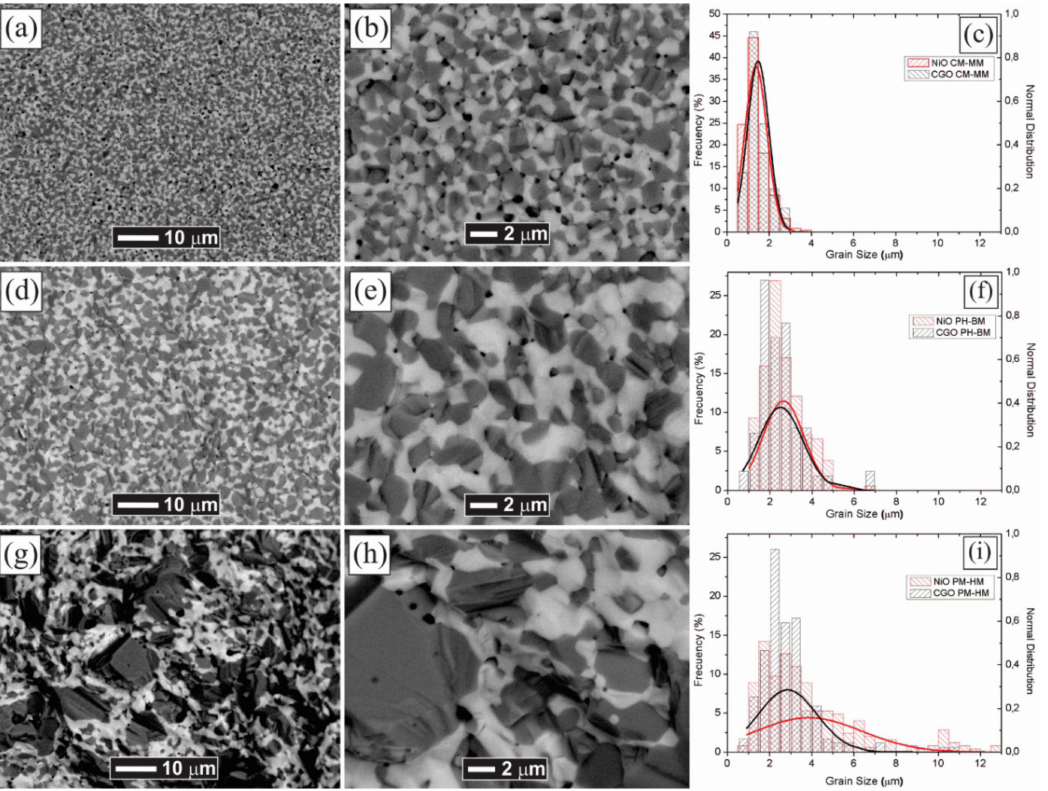
Figure 7. SEM images of the fracture surfaces for the sintered samples processed through ( a , b ) CM, ( d , e ) BM, and ( g , h ) HM methods. Grain size distribution for the sintered samples processed through ( c ) CM, ( f ) BM, and ( i ) HM